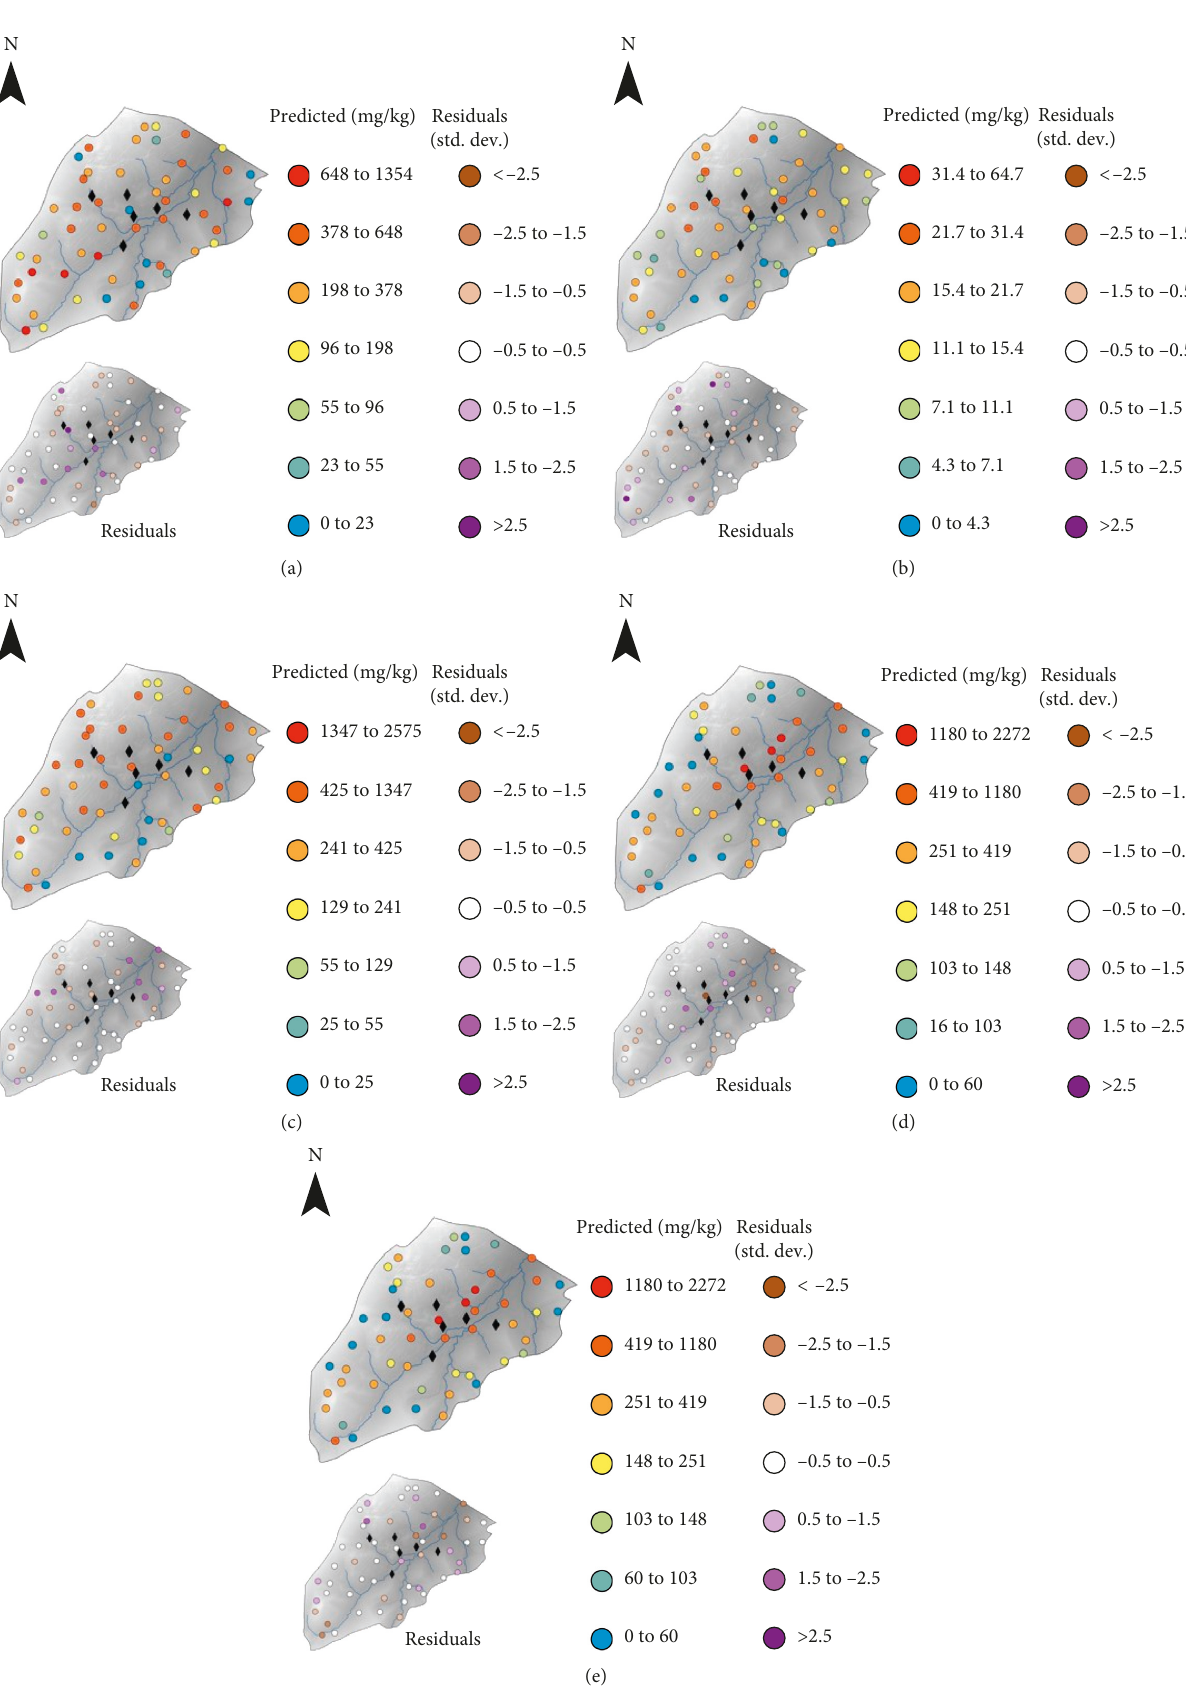
Figure 5: Spatial regression model results showing predicted concentrations and residuals for (a) zinc, (b) copper, (c) manganese, (d) lead, and (e)